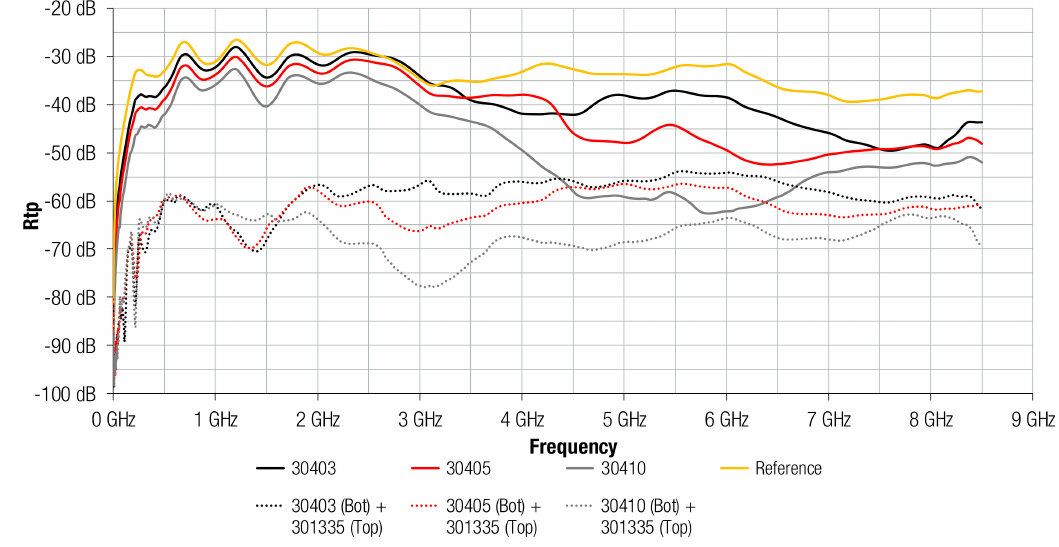
Figure 9. Re-radiation parameter of 304 absorber material with different thicknesses and Al layer integrated.